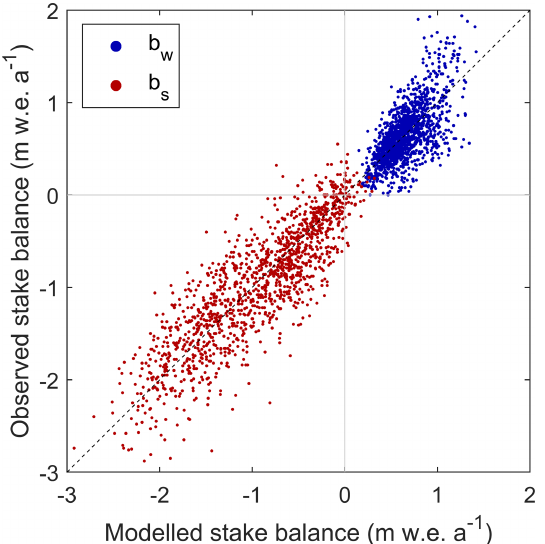
Figure 3. Simulated vs. observed summer and winter balance for all available stake data from eight glaciers (Table